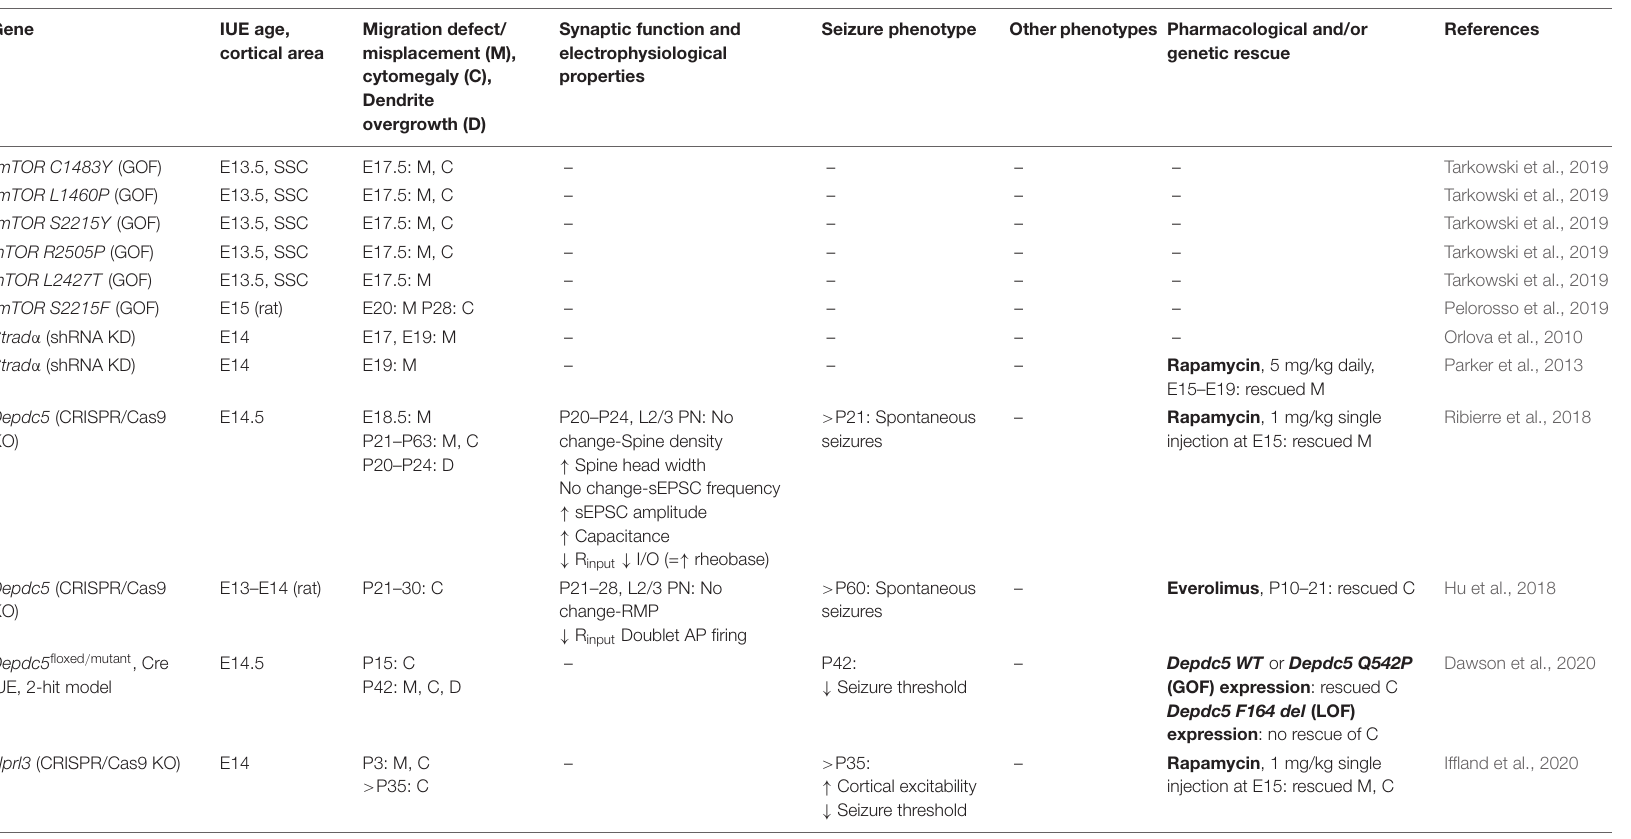
The table is organized by position of genes in the PI3K-mTOR pathway and GATOR1 complex, variant, and date of publication. All gene variants activate mTORC1 signaling. Stars in front of gene name denote human de novo somatic ( ∗ ) or germline ( ∗∗ ) mutations that have been identified in MCD (e.g., HME, FCDII) and epilepsy. All studies were done in mice unless noted otherwise. Targeted cortical areas are listed if they were specified in the original publication. Ages refers to when IUE was performed and the timepoints of pathological and/or behavioral evaluation. GOF, gain-of-function; LOF, loss-of-function; WT, wildtype; KO, knockout; KD, knockdown; E, embryonic day; P, postnatal day; SSC, somatosensory cortex; CC, cingulate cortex; mPFC, medial prefrontal cortex; L2/3 PN, layer 2/3 pyramidal neurons; RMP, resting membrane potential; R input , input resistance; R membrane , membrane resistance; I/O, input/output; mIPSC, miniature inhibitory postsynaptic current; mEPSC, miniature excitatory postsynaptic current; sEPSC, spontaneous excitatory postsynaptic current; eEPSC, evoked excitatory postsynaptic current; AP, action potential; DN, dominant negative; NF,